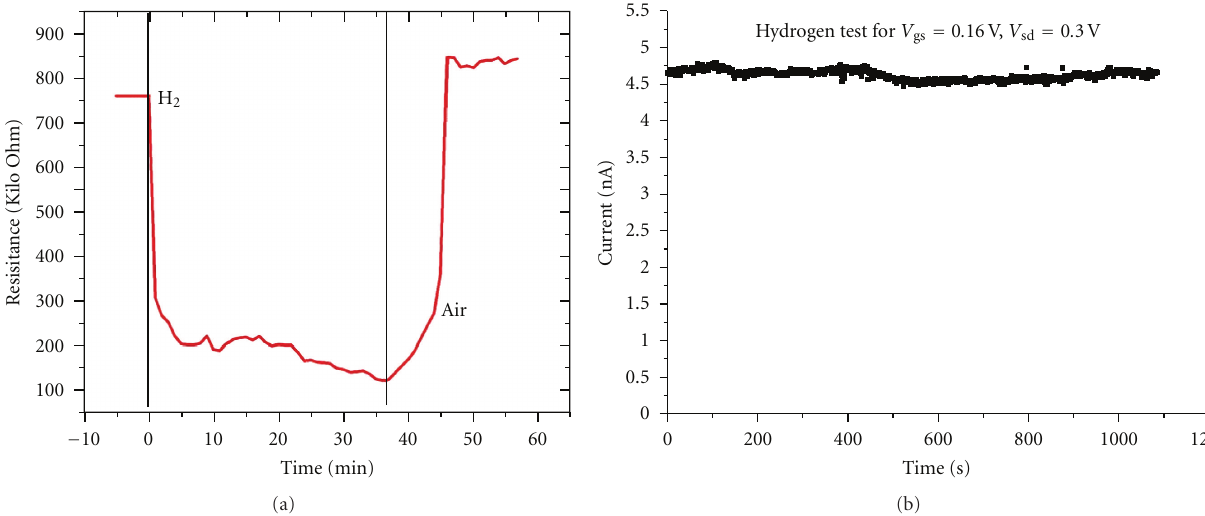
Figure 12: Comparison of sensor properties at H 2 containing atmospheric environments. (a) Palladium nanowire as hydrogen sensor, comparison [29], shows a pronounced answer in terms of increased conductivity. (b) The anodized Ti nanowire FET shows no response to